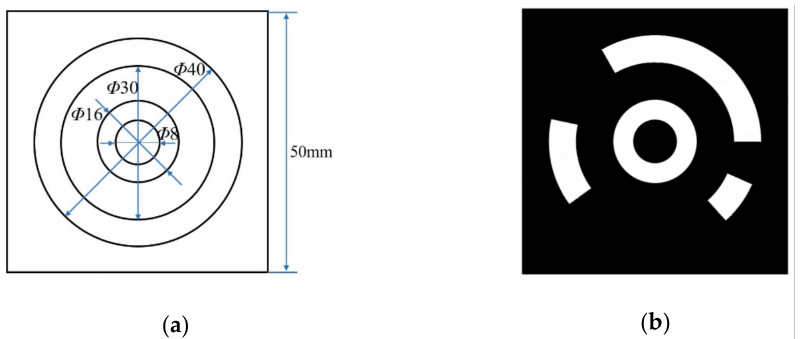
Figure 5. ( a ) Design scheme of the concentric circular coded target (CCCT); ( b ) One example of the CCCTs.